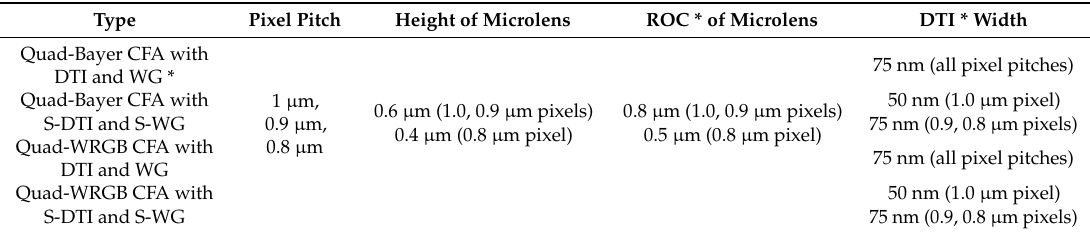
Table 1. Simulation conditions.